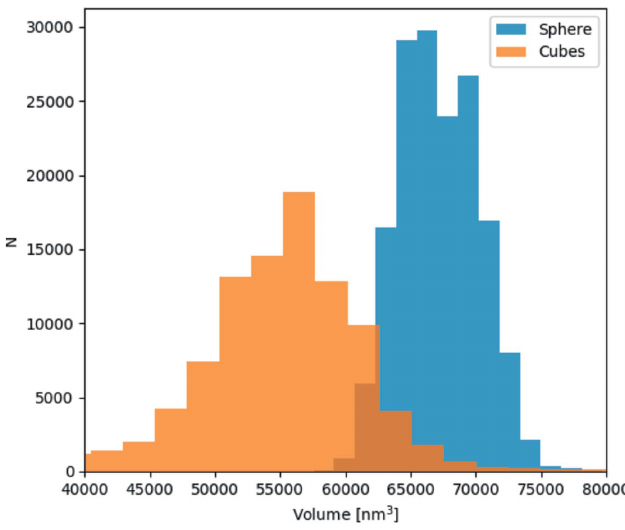
Figure 9 Volume distribution of cubic particles (orange) and spherical particles (blue).